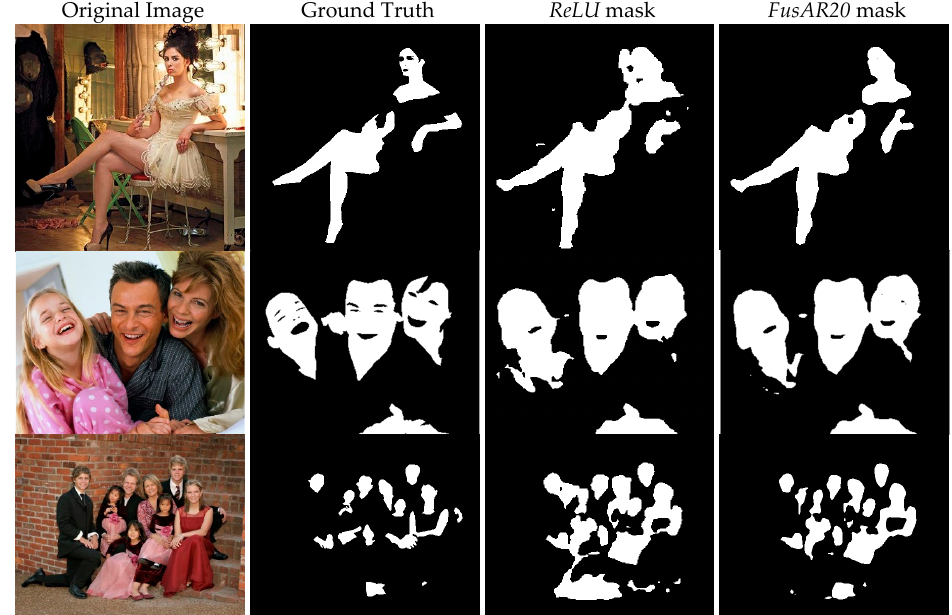
Figure 3. Visual comparison of segmentation results on images from Pratheepan dataset (from left to right): original input image, ground truth, ReLU output mask, and FusAR20 output mask.